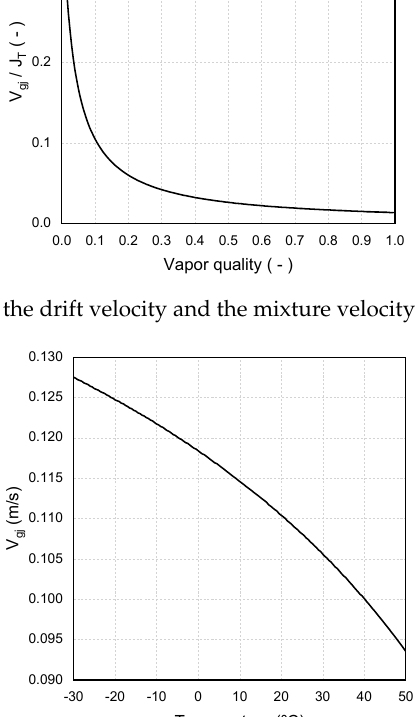
Figure 13. Drift velocity in function of the saturation temperature for R134a. 5. Conclusions A study of void fraction measurement techniques, experimental databases and correlations for two-phase flows in small-diameter channels was performed and led to the following conclusions: -